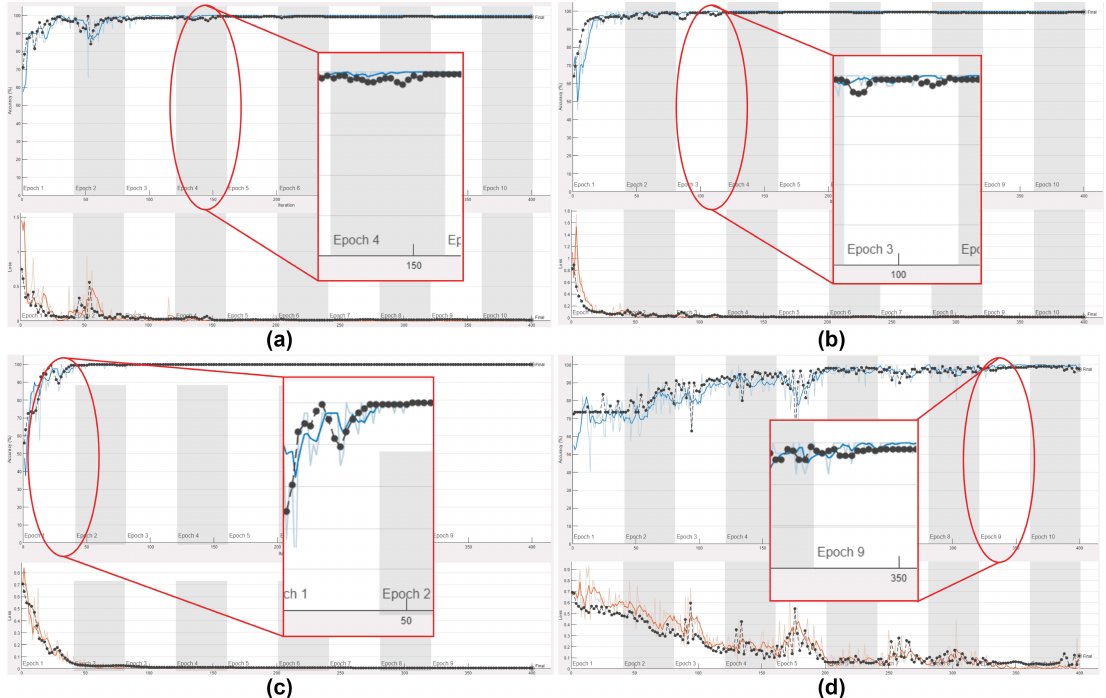
Figure 13. Training results: ( a ) AlexNet; ( b ) GoogLeNet; ( c ) ResNet-50; ( d ) proposed